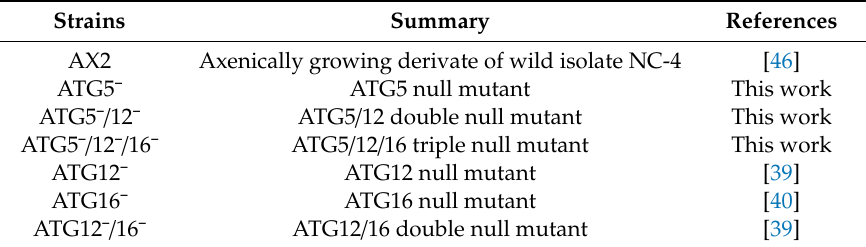
Table 1. D. discoideum strains used in this